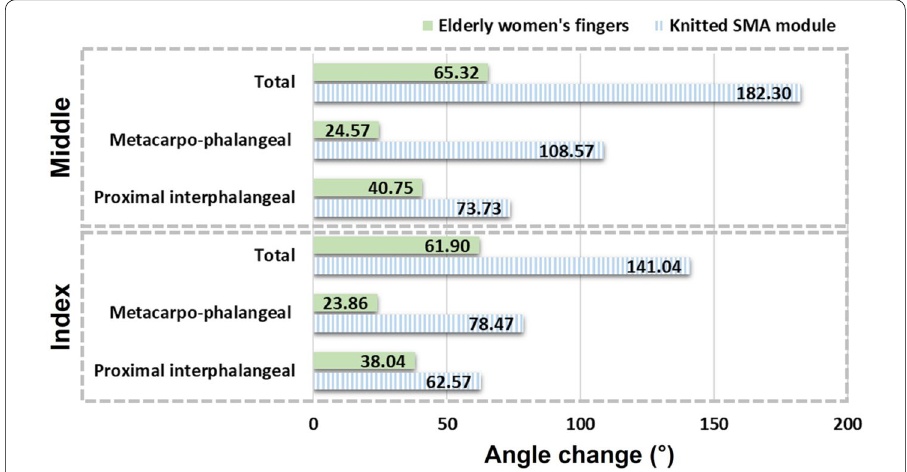
Fig. 8 Comparison of finger‑bending angles for the gripping aid versus participant finger movements